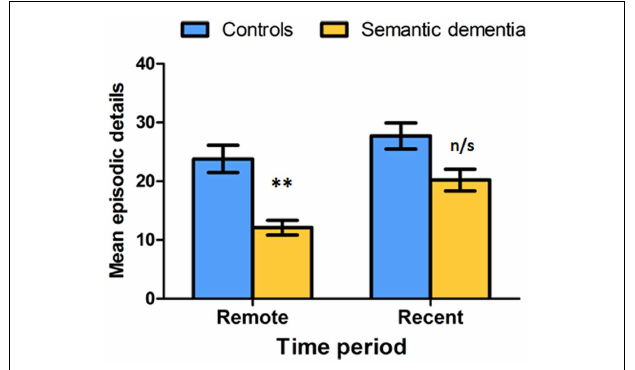
FIGURE 2 | Differential impairment of remote versus recent autobiographical memory in semantic dementia compared to healthy controls during free recall on theAutobiographical Interview (AI). Error bars represent standard error of the mean. ** P < 0.0001; n/s, not significant. Data adapted from Irish et al.